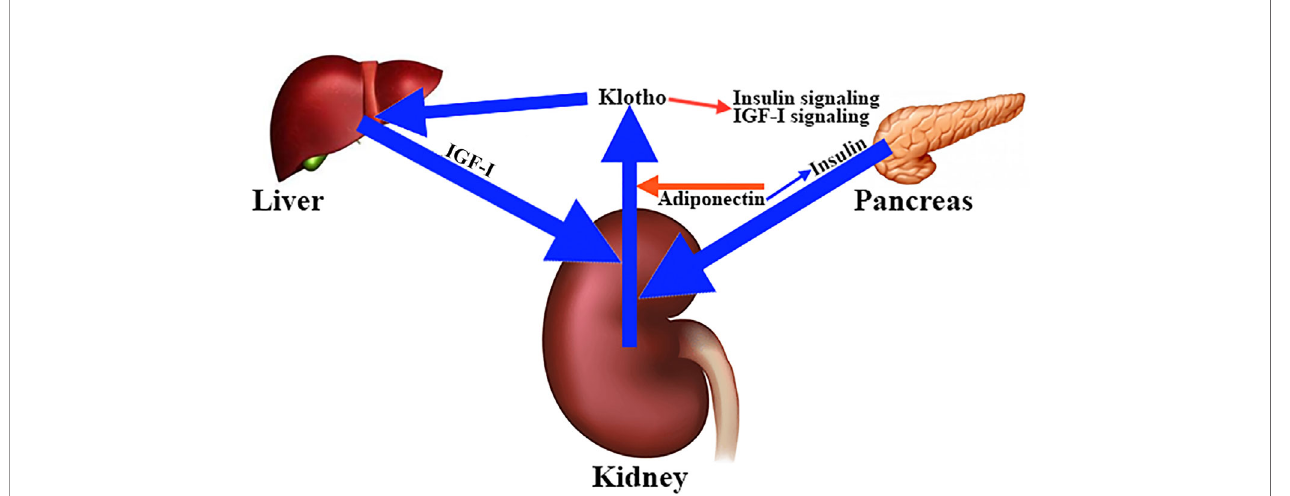
FIGURE 7 | Main factors involved in the regulation of klotho secretion in the kidney. The kidneys are the main source of circulating klotho. Different hormones and factors involved in mineral homeostasis contribute to the regulation of klotho secretion. For example, adiponectin decreases renal klotho secretion (red arrow), while insulin stimulates cleavage and release of full-length soluble klotho (blue arrow), an effect that is sensitized by adiponectin (blue arrow). The same effect on klotho secretion is carried out by IGF-I (blue arrow), whose hepatic production appears to be stimulated by klotho (blue arrow). This is curious because klotho inhibits the insulin and IGF-I signaling pathways (red arrow).